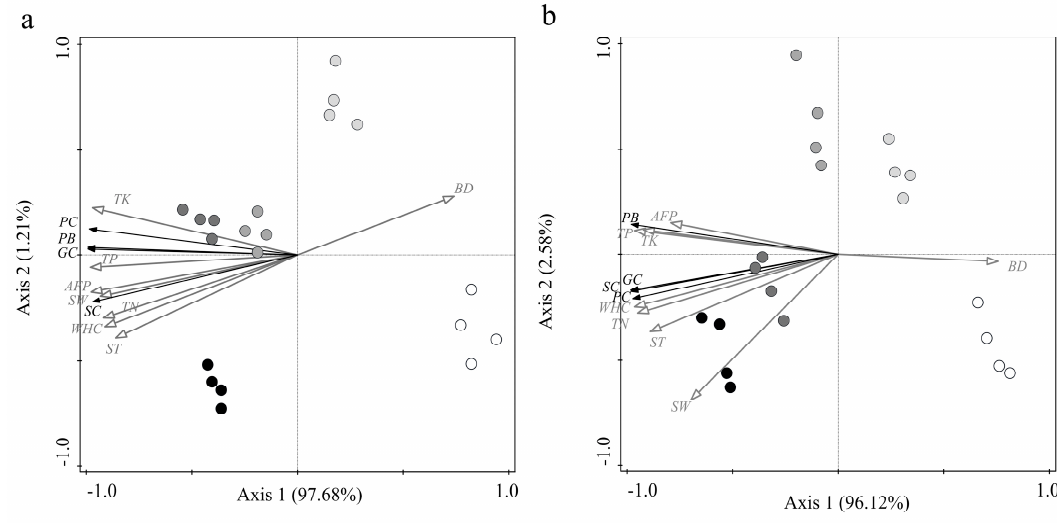
Figure 3. The redundancy analysis (RDA) shows the relationships among soil physical properties, soil nutrients, and carbon content of the green roof components. ( a ) Analysis of different biochar treatments. ( b ) Analysis of different sludge treatments. The different treatments were: CK, urban natural soil, no biochar or sludge ( ); 5% SB (5% SS), 5% biochar (sludge) + soil ( ); 10% SB (10% SS), 10% biochar (sludge) + soil ( ); 15% SB (15% SS), 15% biochar (sludge) + soil ( ); 20%SB (20%SS), 20% biochar (sludge) + soil ( ). The acronyms are: soil temperature (ST), soil moisture (SW), total nitrogen (TN), total phosphorus (TP), total potassium (TK), water holding capacity (WHC), air-filled porosity (AFP), bulk density (BD), total carbon content of the green roof (GC), carbon content of the plants (PC), biomass of the plants (PB), and carbon content of the substrate (SC). Table 2. Correlation between the additives and the properties of the roof substrate.